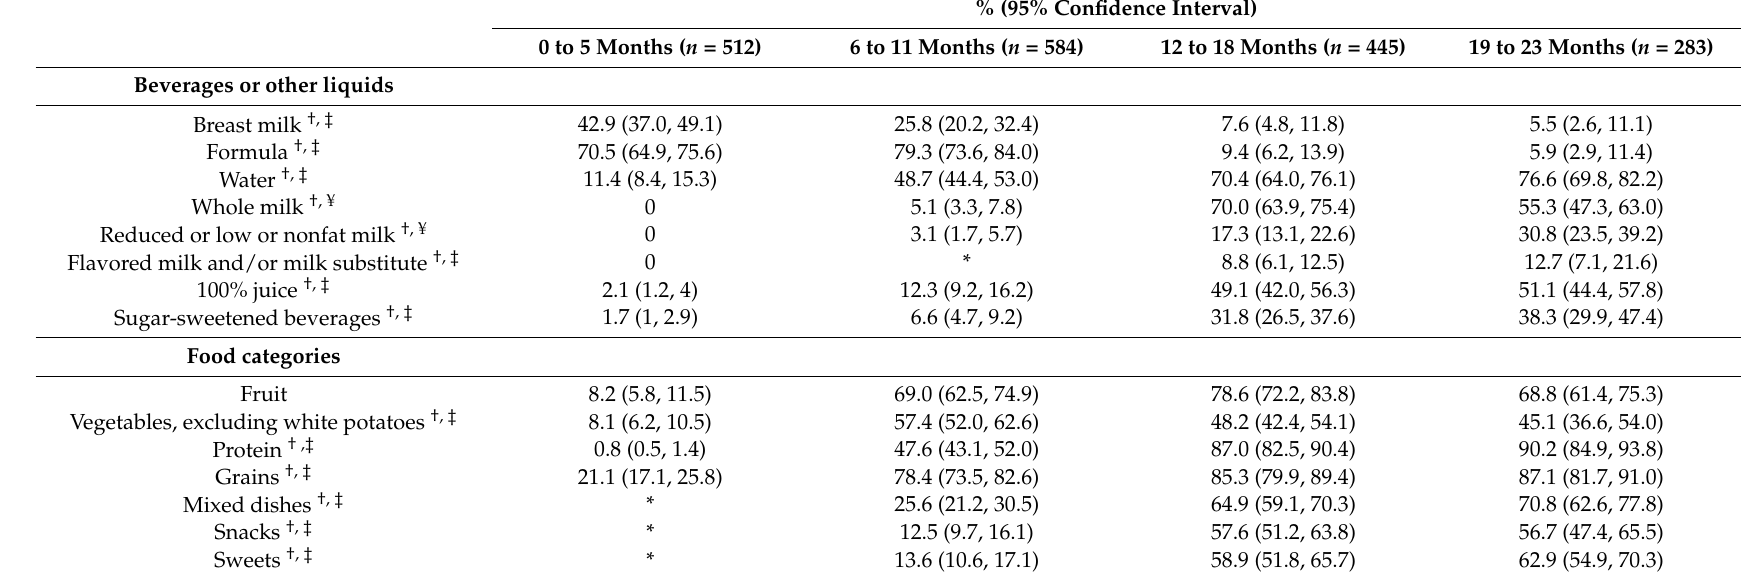
Table 2. Percentage of U.S. children birth to 23 months of age 1 consuming any beverages or other liquids and different food categories 2 by age, NHANES